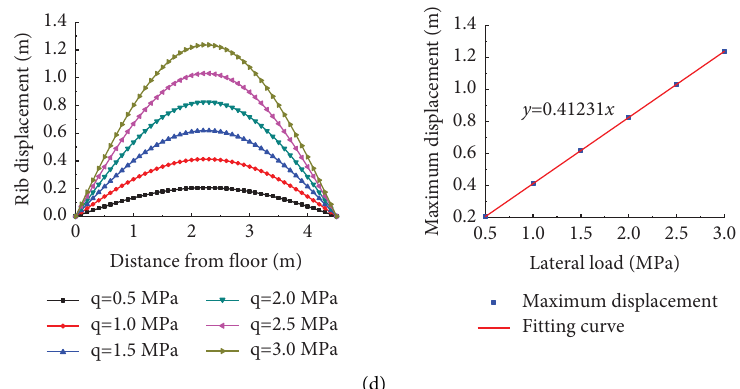
Figure 11: Deformation characteristics of the coal rib: (a) stifness efect; (b) roof load efect; (c) roadway height efect; (d) lateral load